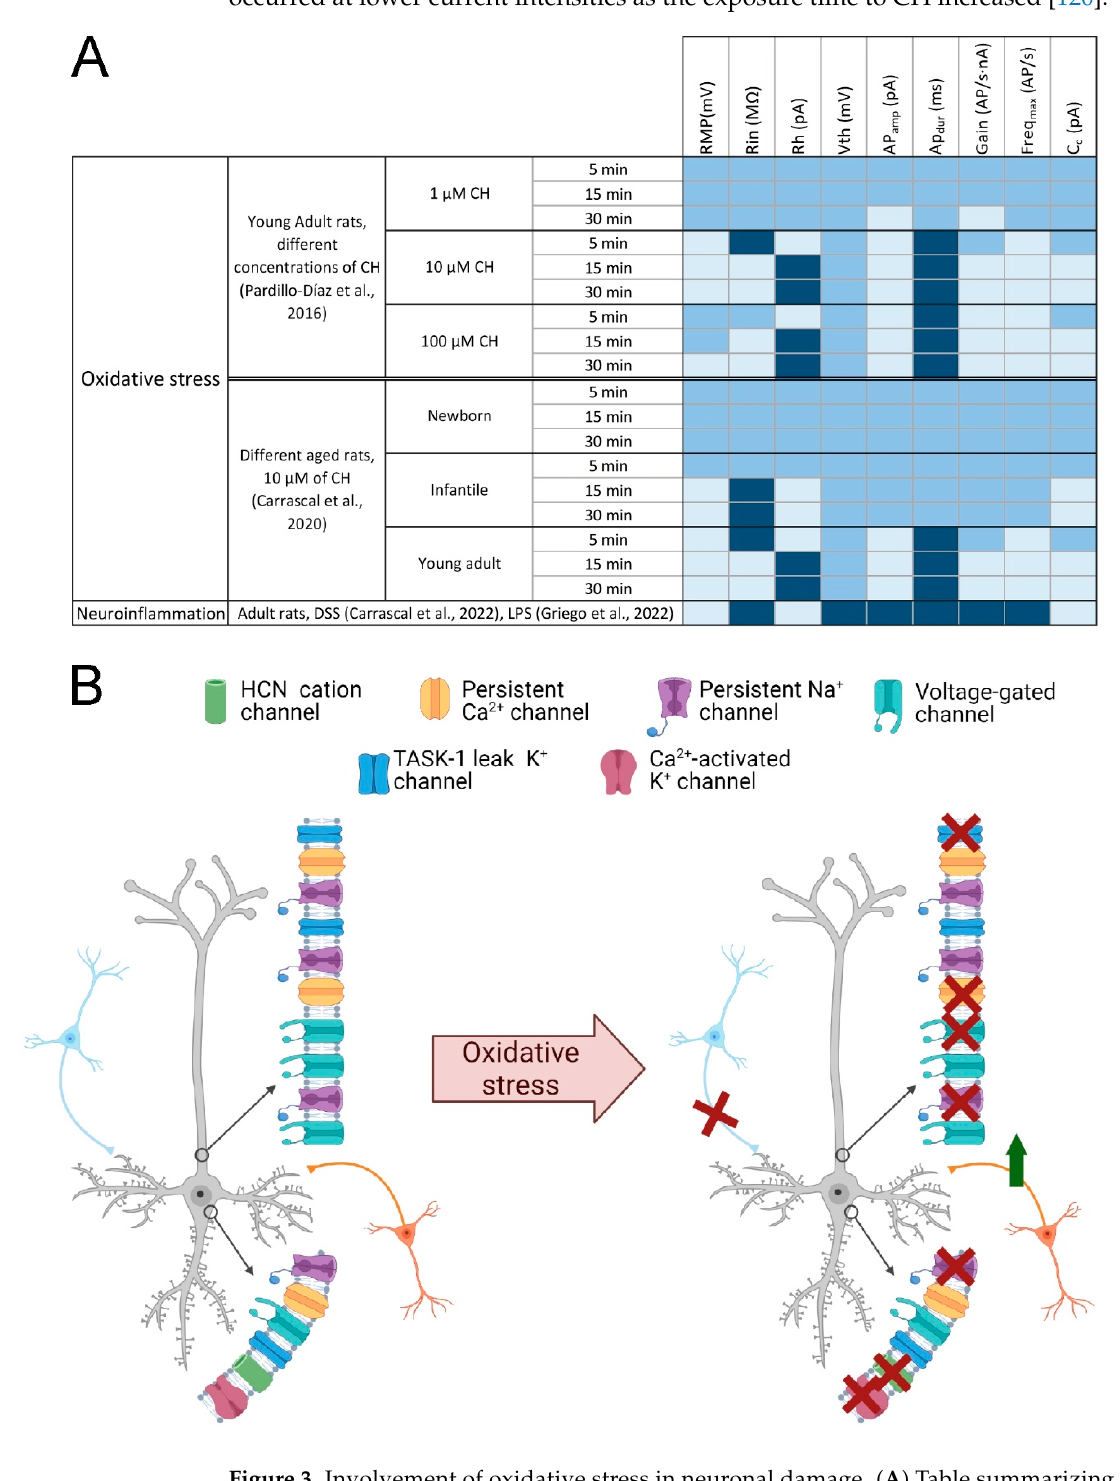
Figure 3. Involvement of oxidative stress in neuronal damage. ( A ) Table summarizing the main changes evoked by oxidative stress and neuroinflammation on motor cortex neurons membrane properties. The electrophysiological parameters that increase under these conditions are repre- sented in dark blue, the parameters that remain similar to control in medium blue and those that decrease in light blue. ( B ) Alterations of ion channels due to oxidative stress. Schematic drawings of two neurons, one unaffected by oxidative stress ( left ) and one affected ( right ); red crosses indicate loss of ion channel activity or loss of synaptic input; the green arrow indicates the increase in syn- aptic inputs; blue neurons represent GABAergic inputs, orange neurons represent glutamatergic inputs. Abbreviatures: AP amp and AP dur , action potential amplitude and duration; C c , cancellation current; CH, cumene hydroperoxide; DSS, dextran sulphate sodium; Freq max , Maximal Frequency;